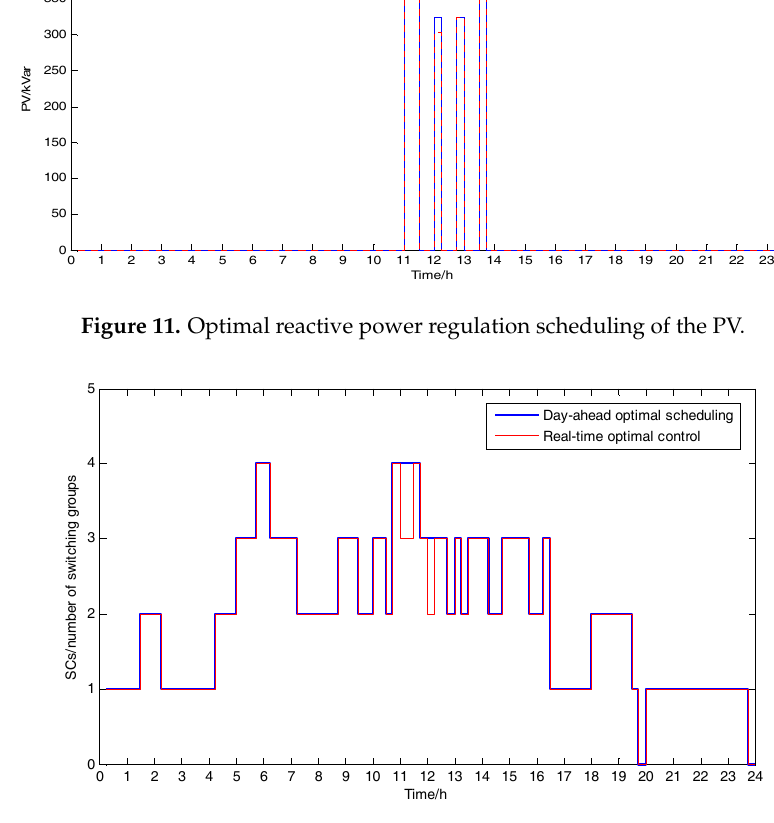
Figure 12. Optimal regulation scheduling of the distributed shunt capacitors (SCs).